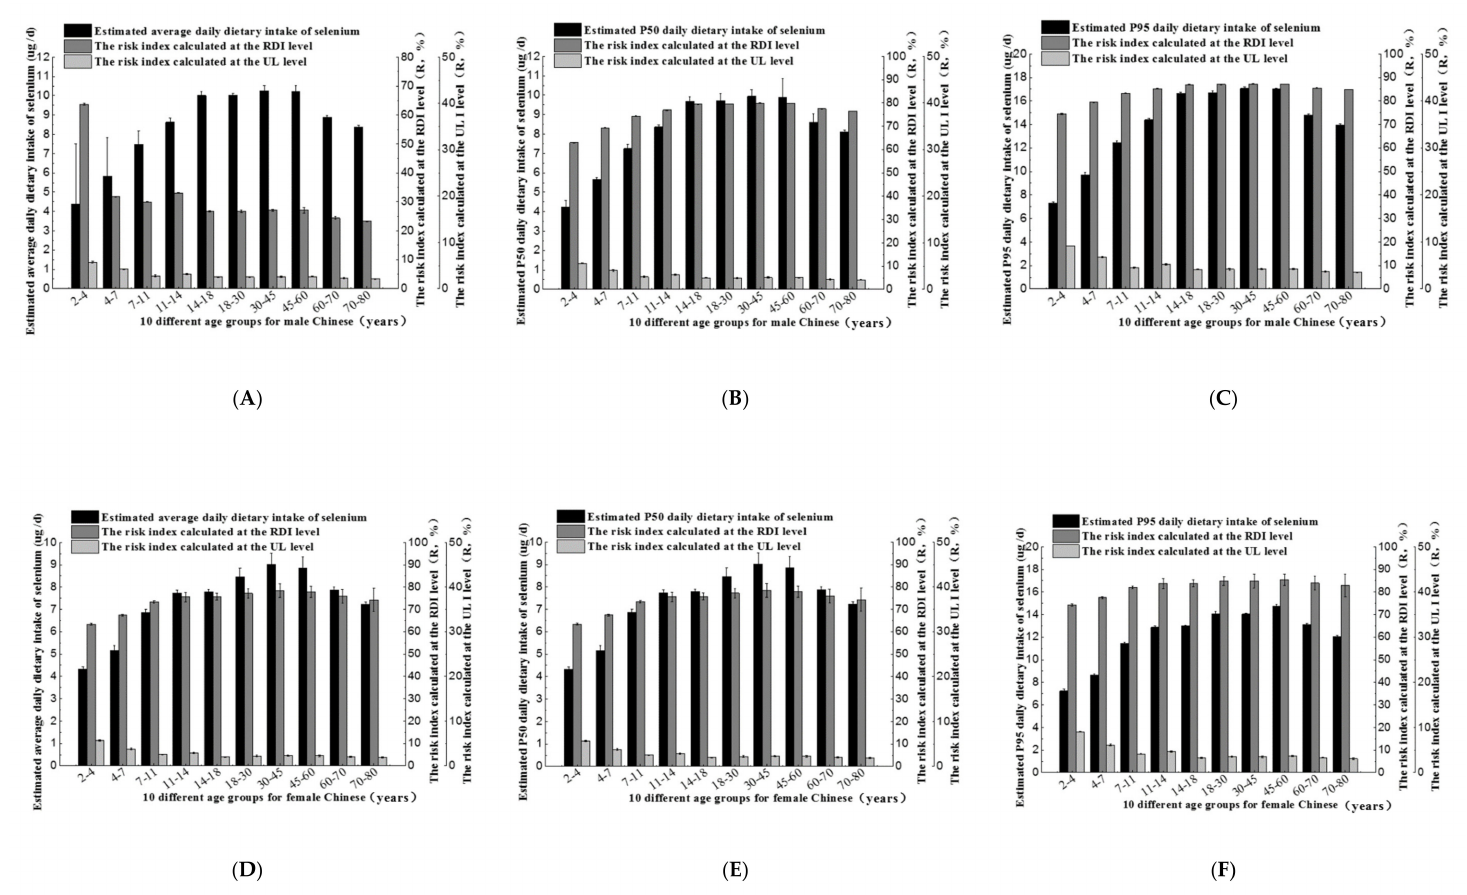
Figure 3. Dietary selenium intake and risk assessment of male ( A – C ) and female ( D – F ) population in di ff erent age groups when they only eat common rice. When the risk index was calculated, the actual daily dietary selenium intake data of male and female population in di ff erent age groups was from the study by Nie JY in 2015 [29] and “dietary guidelines for Chinese residents in 2016”. The RDI and UL data of male and female population in di ff erent age groups were selected by reference to selenium intake recommendations from the FAO (Food and Agriculture Organization of the United Nations) / WHO (World Health Organization) and the NNFA (US National Nutritional Foods